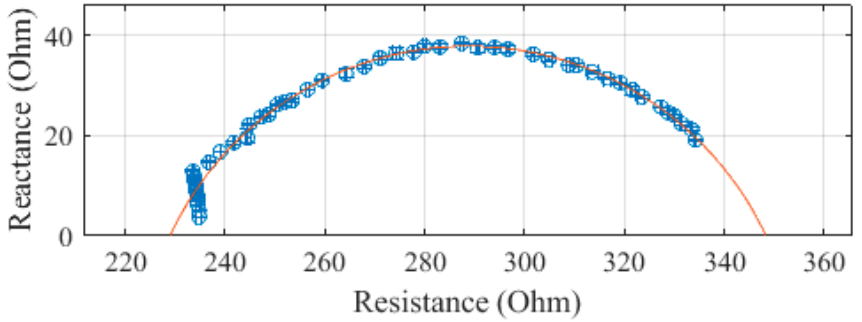
Figure 11. Cole–Cole plot of the leg impedance of subject 1 measured with a Multiscan 5000.